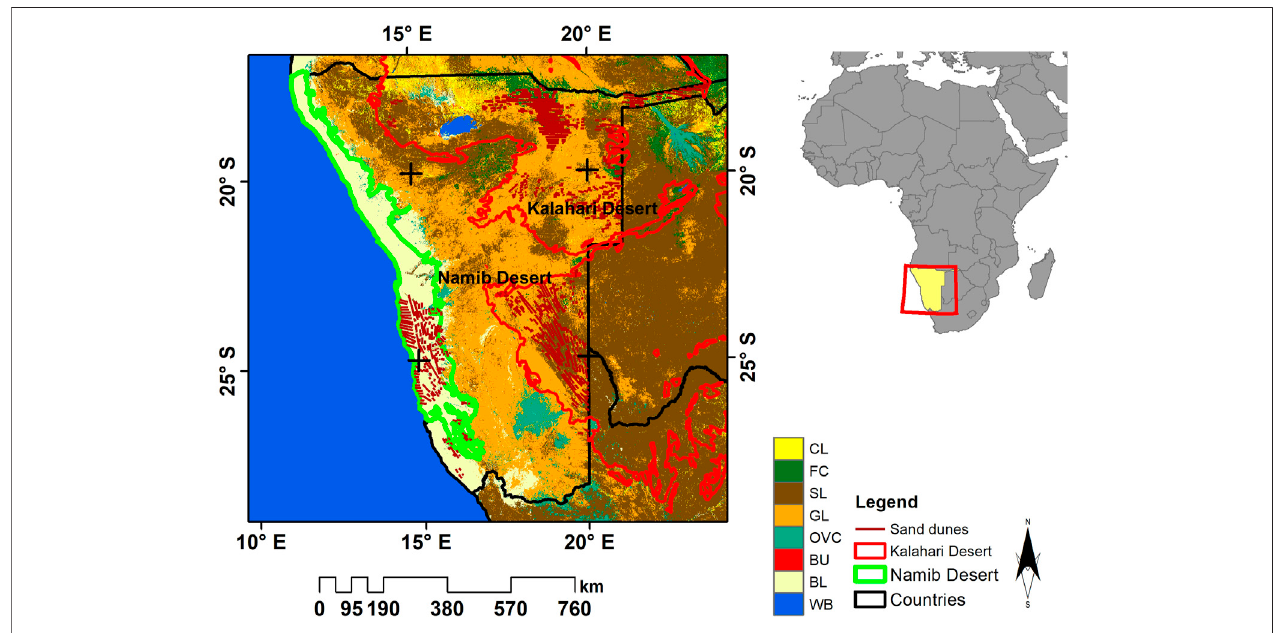
FIGURE 1 | Locations of deserts and selected pans in southern